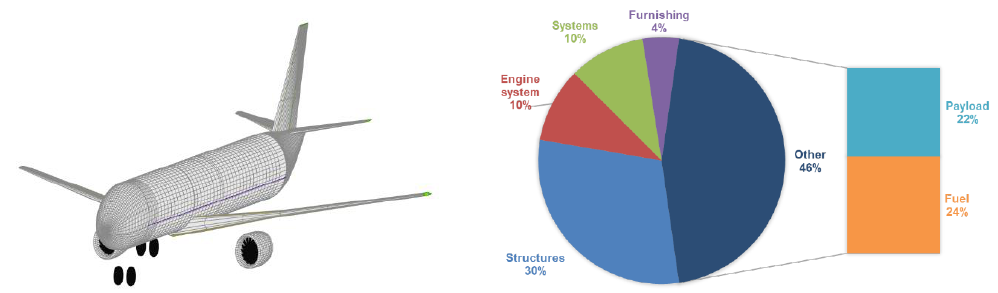
Figure 7. Typical weight breakdown of a short-to-medium range aircraft (data source [14]).